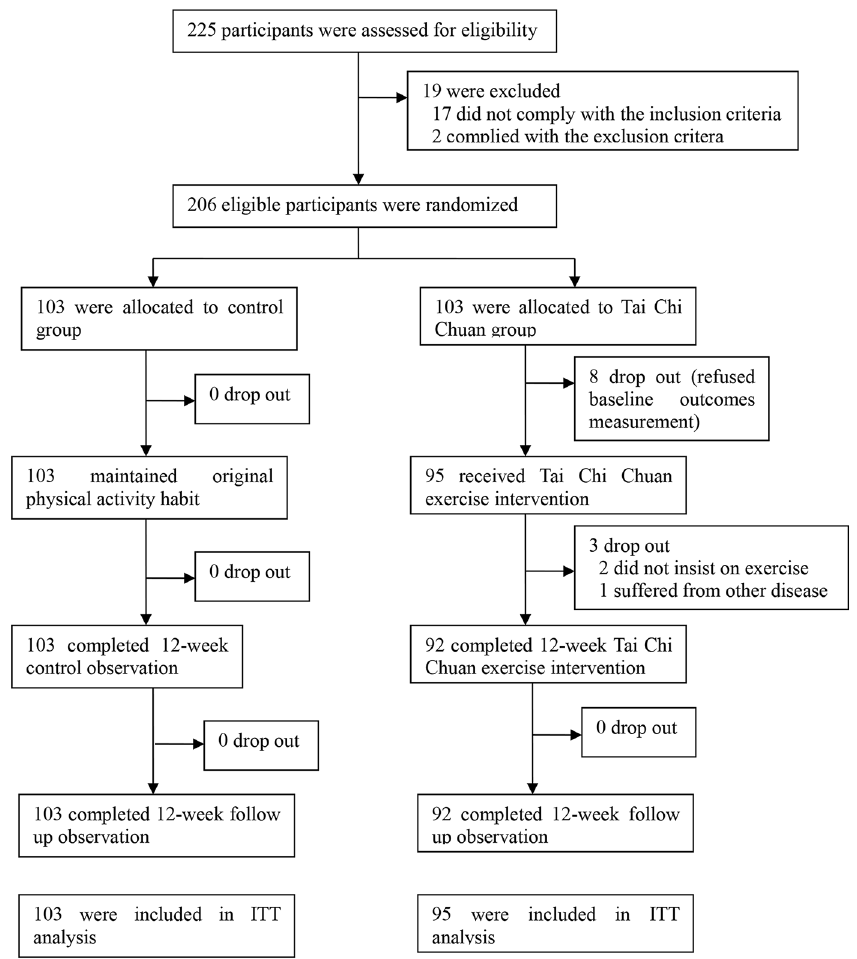
Fig 1. Participant flow through the study reported in a CONSORT